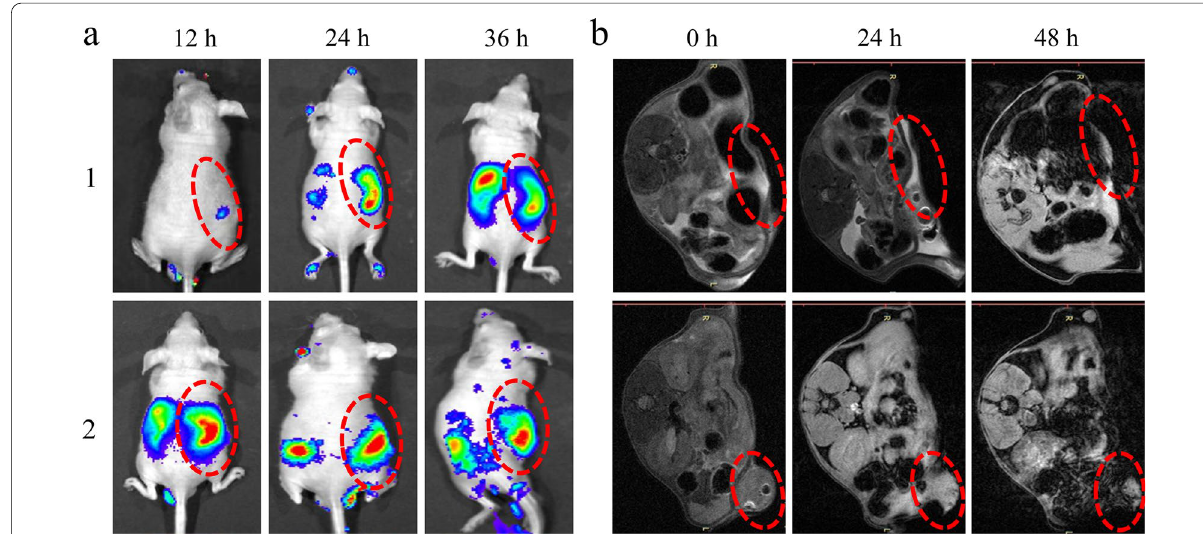
Fig. 6 a In vivo luminescence imaging and b MRI of 4T1-bearing mice at designed time after treated with MnO 2 /ZIF-8/ICG (1) and FA-EM@MnO 2 / ZIF-8/ICG (2) nano-platform. The red dashed line represents tumor tissue